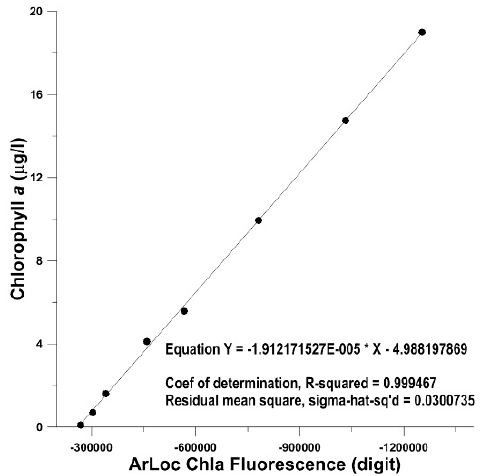
Figure 4. Linear regression between laboratory spectrophotometric chlorophyll a concentration and ArLoC chla fluorescence.